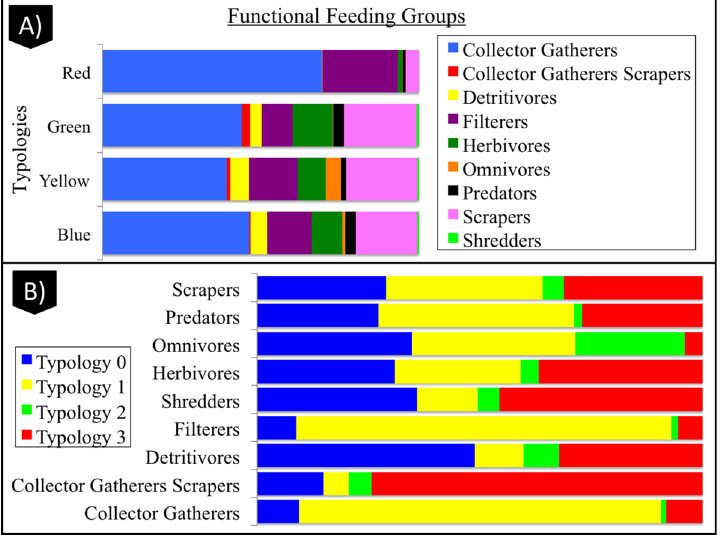
Figure 8. Proportional bar charts depicting ( A ) functional feeding groups contained in each typology; and ( B ) functional feeding group distribution amongst typologies.